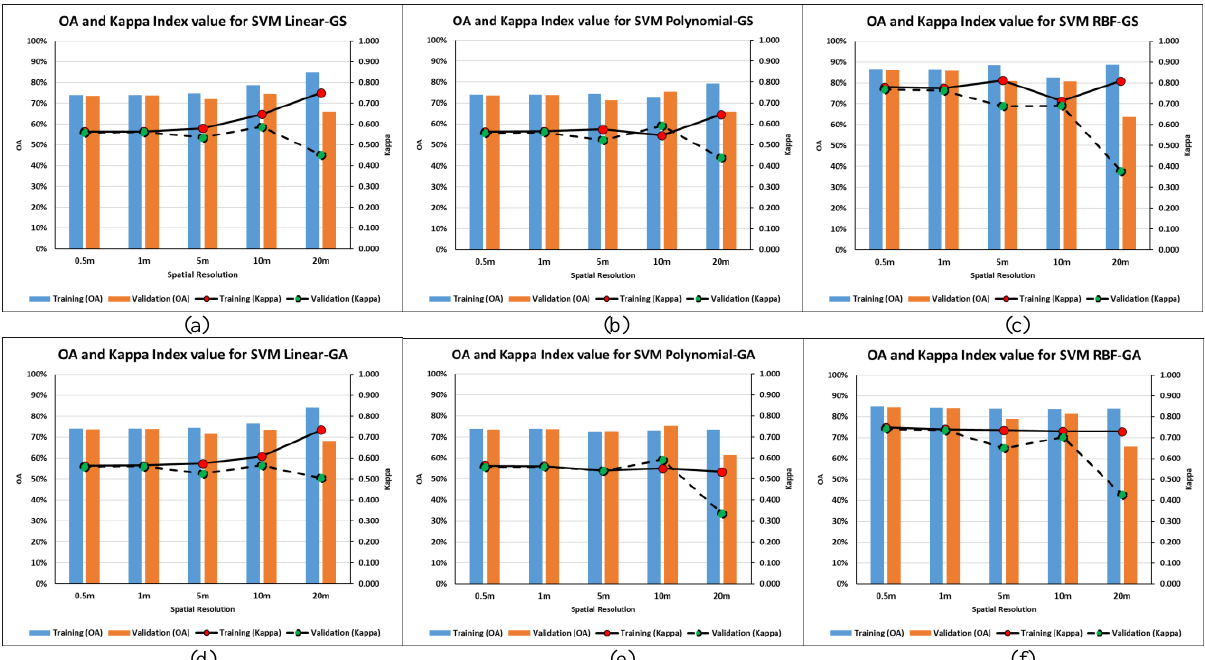
Figure 3 . Overall accuracy and kappa coefficient of classified landslide activity for deep seated, translational landslide with different spatial resolution using (a) SVM Linear-GS, (b) SVM Polynomial-GS, (c) SVM RBF-GS, (d) SVM Linear-GA, (e) SVM Polynomial-GA, and (f) SVM RBF-GA